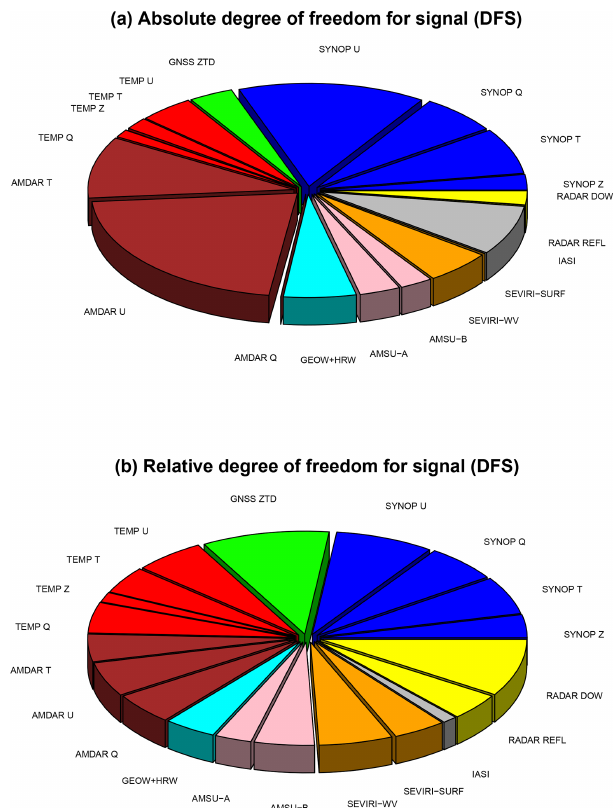
Figure 2. The absolute (a) and relative (b) DFS scores computed in AROME/Hungary 3D-Var experimental analyses for the period 5– 15 June 2017. The considered observations in DFS computation are the following: SYNOP (parameter U , Q , T , Z ) with blue, TEMP (parameter U , T , Q , Z ) with red, AMDAR (parameter U , T , AM- DAR Q ) with maroon, GEOW + HRW (parameter U ) with cyan, RADAR (parameter reflectivity, radial wind) with yellow, AMSU-A and AMSU-B (parameter Tb) with pink, SEVIRI-WV and SEVIRI- SURF (parameter Tb) with orange, IASI (parameter Tb) with grey and GNSS (parameter ZTD) with